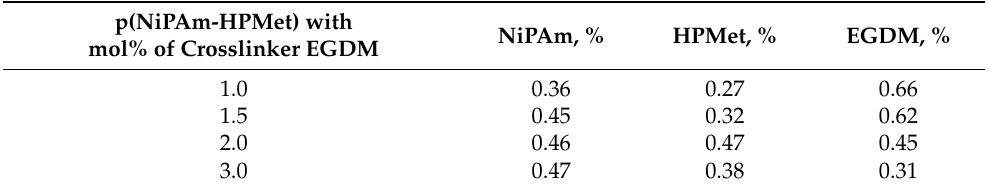
Table 1. Amounts of residual reactants NiPAm, HPMet and EGDM in relation to the initial amount in the reaction mixture, in mass%.